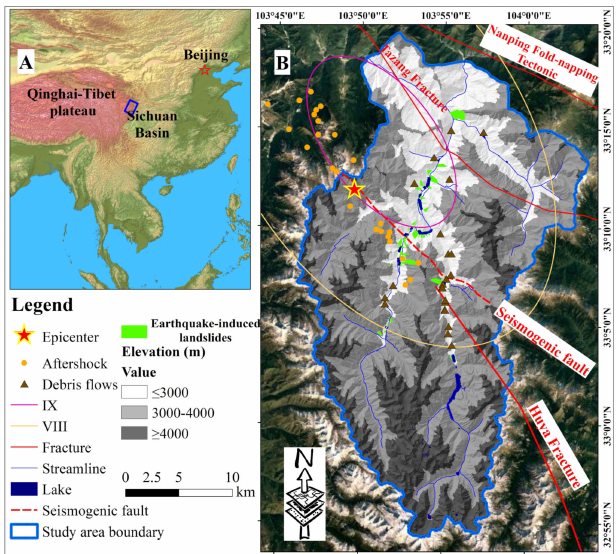
Figure 2. Geomorphological and geological settings of the study region. ( A ) Location of study region; ( B ) distribution of elevation and earthquake-induced geohazards in the park; the base map with a spatial resolution of 16 × 16 m was downloaded from Google earth, and the spatial resolution of DEM is 10 m × 10 m. “IX” and “VIII” refer to seismic intensity VIII and IX, respectively.